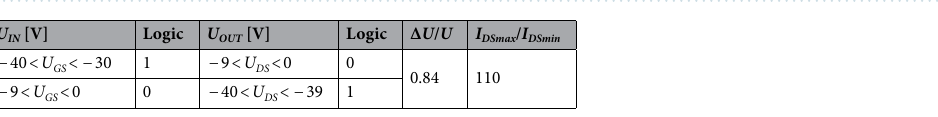
Figure 5. Output curves of the transistor with the load line (straight black line). The voltages Δ U , Δ U 1 , and Δ U 2 are marked under the upper scale. The ranges of the logic states are marked as gray areas. On the right scale, the maximum and minimum currents are marked ( a ). Graphical symbol of the NOT logic gate ( b ). Serial connection of NOT logic gates ( c ).